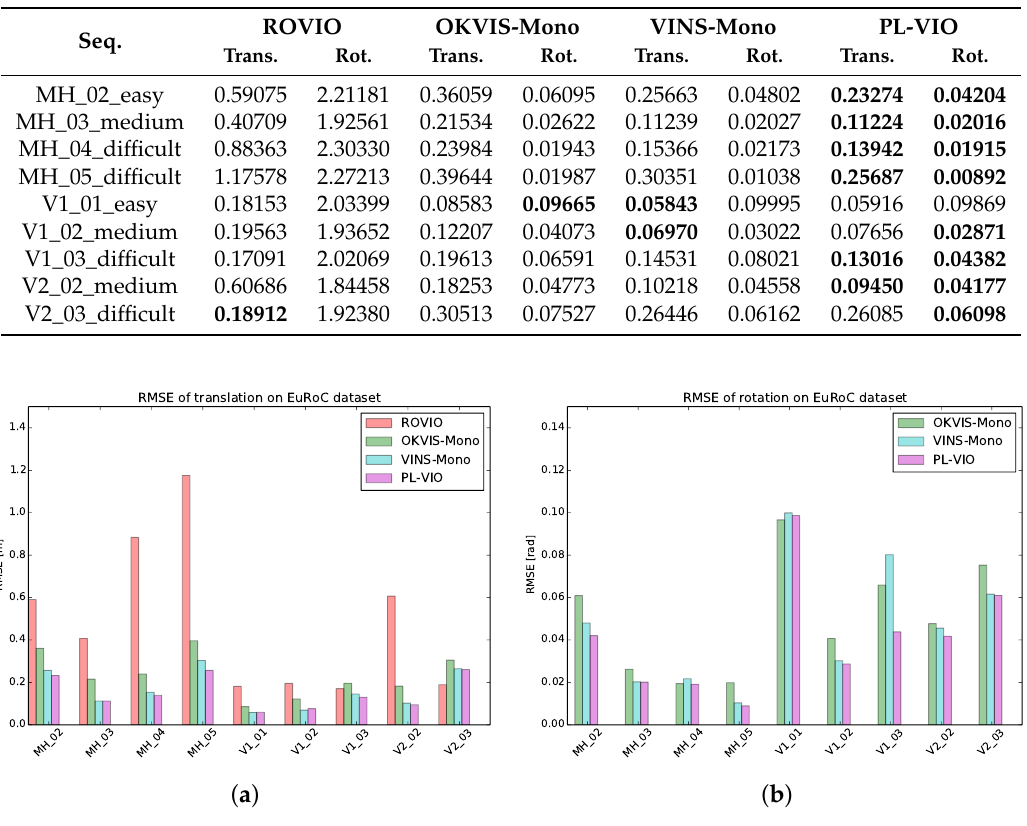
Figure 6. RMSEs for ROVIO, OKVIS-Mono, and Vins-Mono without loop closure, and for the proposed PL-VIO using the EuRoc dataset. ( a ) RMSEs in translation. ( b ) RMSEs in rotation. The rotation errors of ROVIO are one order of magnitude higher than those of other three methods, so its result is not reported in ( b